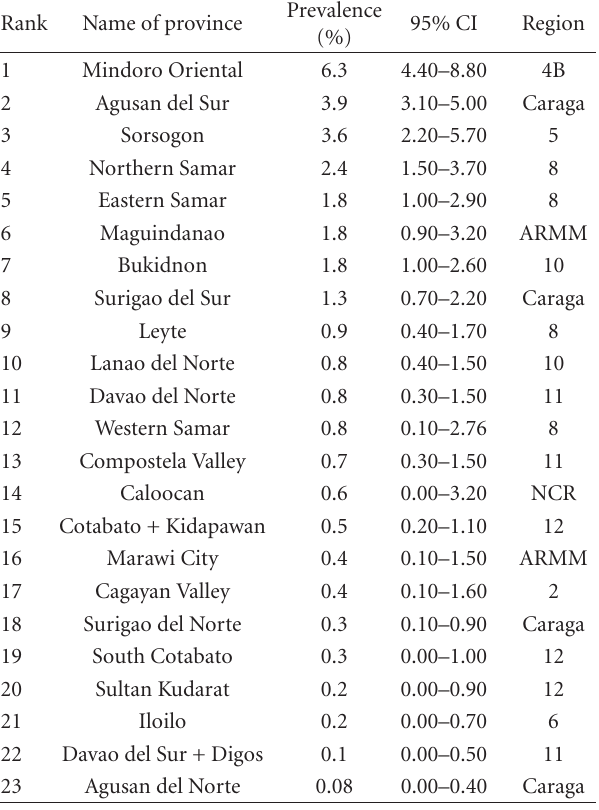
Table 2: Ranking of provinces in Mindanao according to prevalence of schistosomiasis, 2005 and 2008.